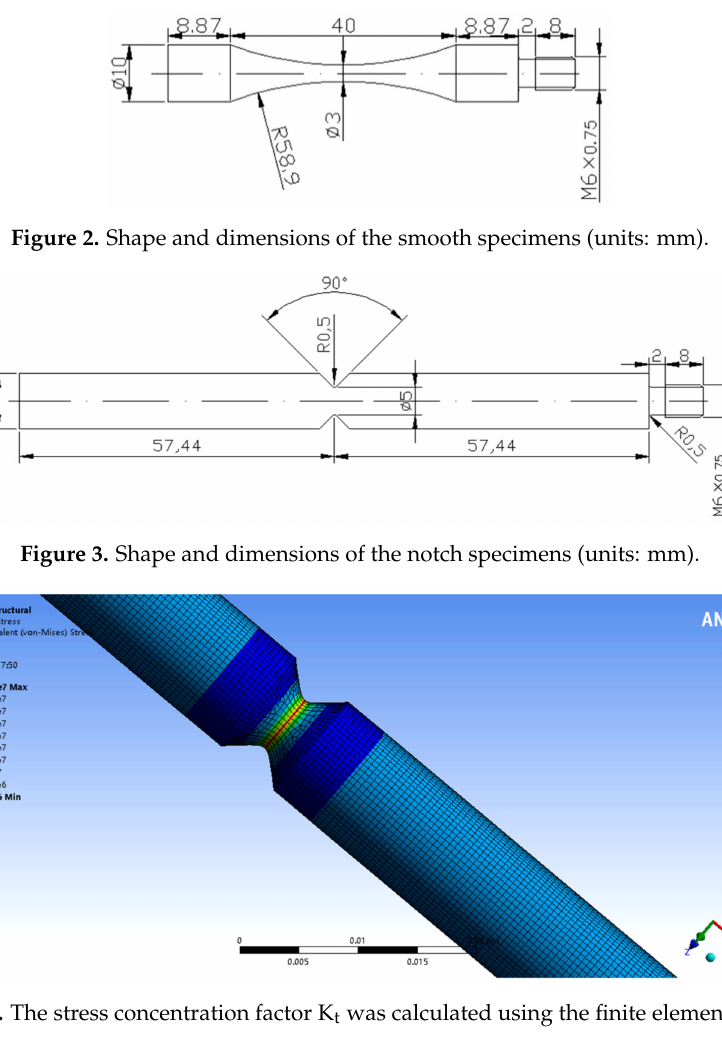
Figure 4. The stress concentration factor K t was calculated using the finite element